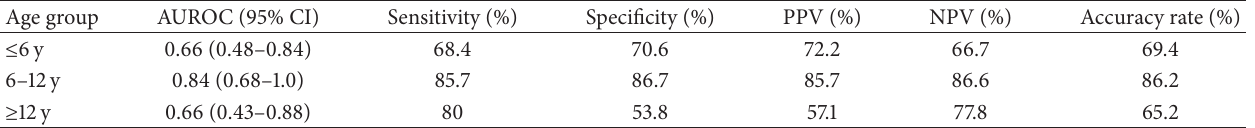
Table 2: The predictive value of the APRI for significant fibrosis ( ≥ S2; cut-off =